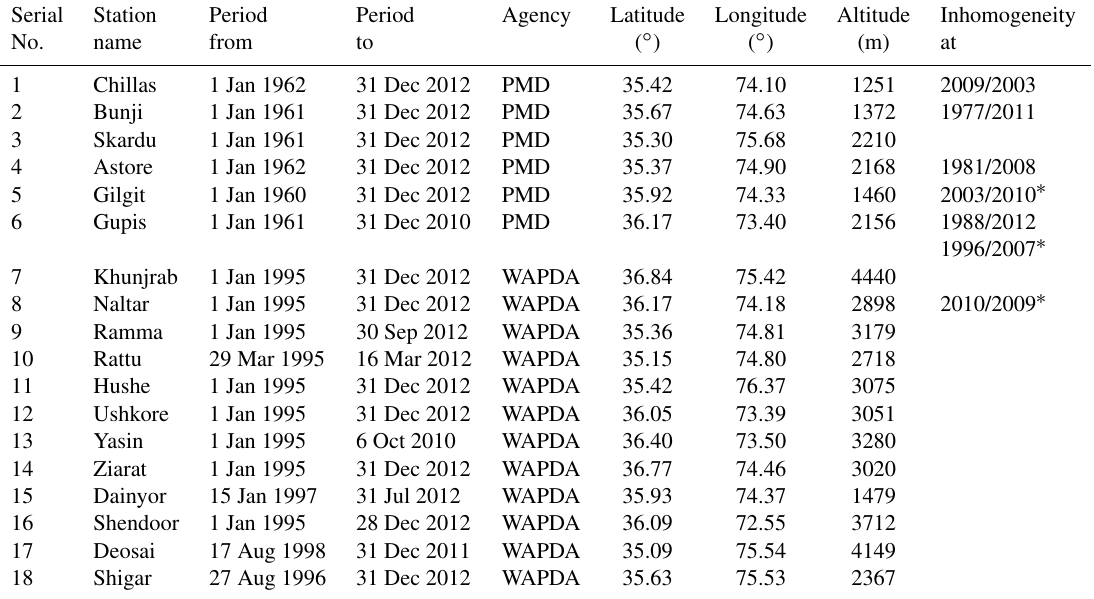
Table 2. Meteorological stations and their attributes. Inhomogeneity is found only in T n over full period of record. Note: asterisk represents inhomogeneity only over the 1995–2012